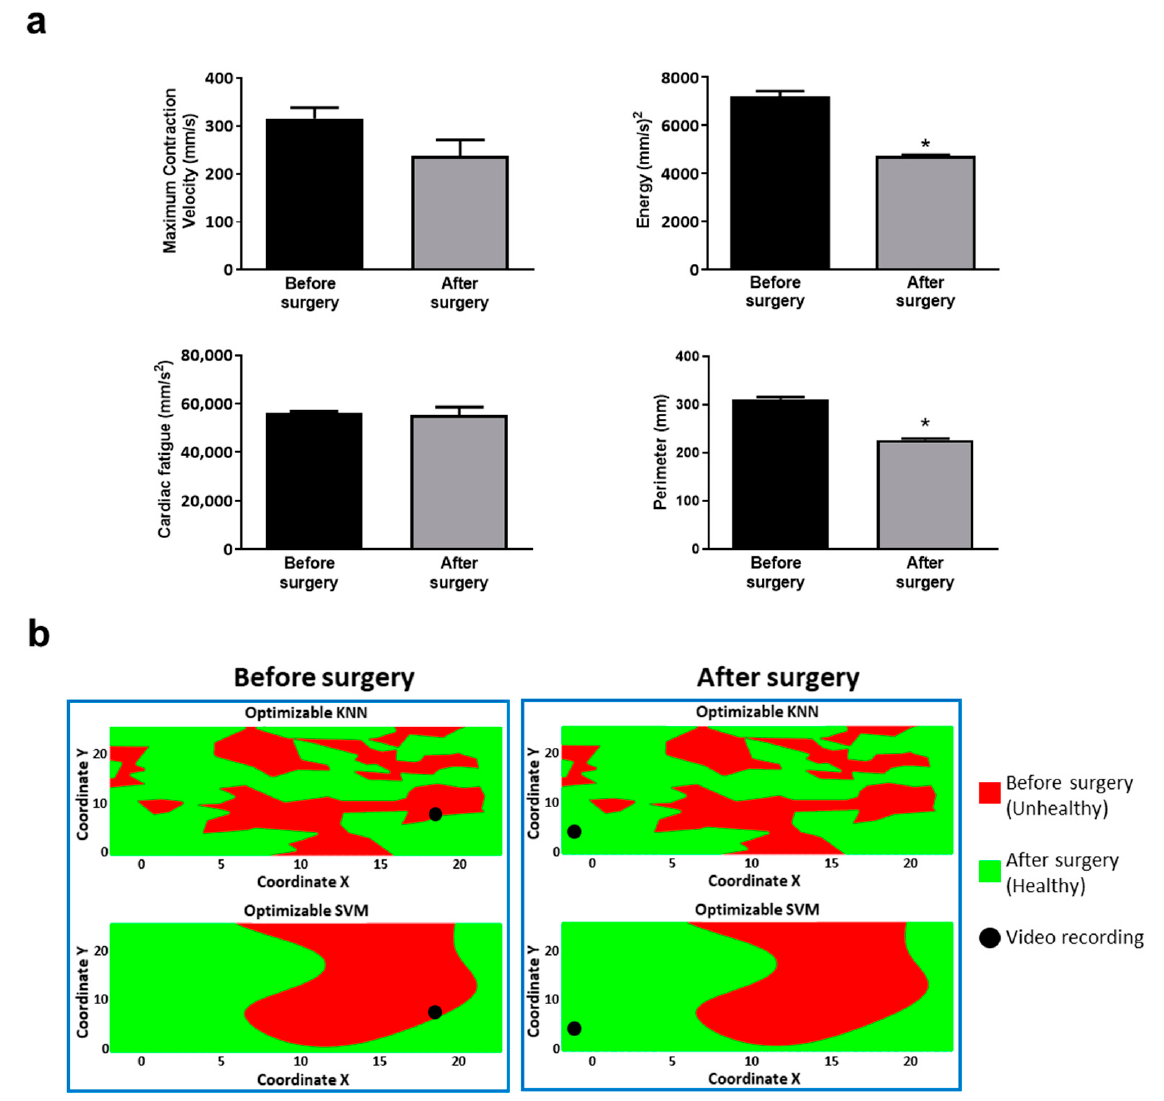
Figure 6. Vi.Ki.E. data and decision surfaces of a ToF patient with a favorable outcome. ( a ) The average Vi.Ki.E. parameters calculated before (black) and after surgery (grey). Top left: Maximum contraction velocity. Top right: energy. Bottom left: force. Bottom right: perimeter. Data are shown as mean ± SEM. * p < 0.05 versus before surgery. ( b ) The decision surfaces of the signal-to-noise ratio (SNR) for both our classification models before (left panels) and after surgery (right panels). The black circle represents the classification/prediction of the patient’s video according to KNN (top) and SVM (bottom) models. The red area is related to a prediction of unhealthy, whereas the green area to a prediction of healthy.